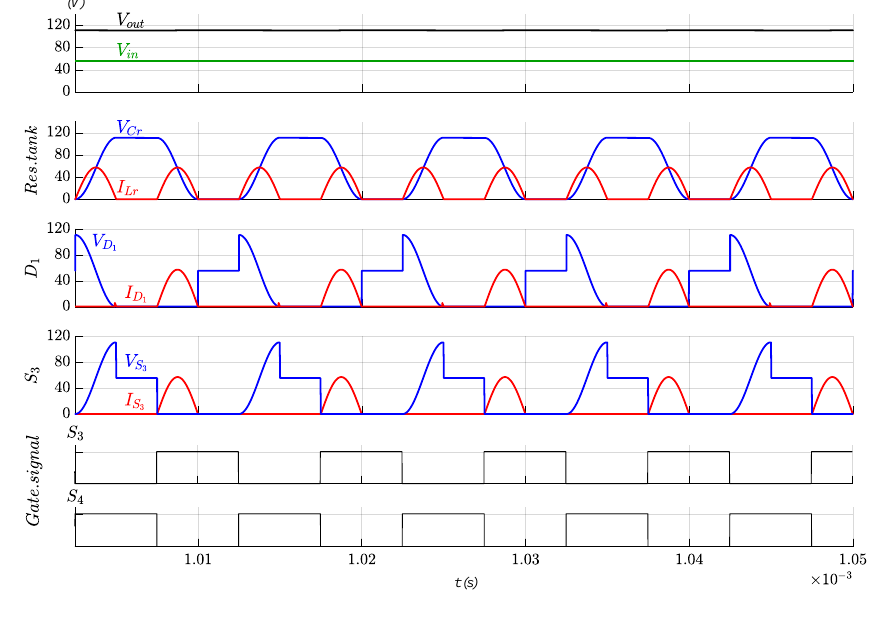
Figure 14. Boost